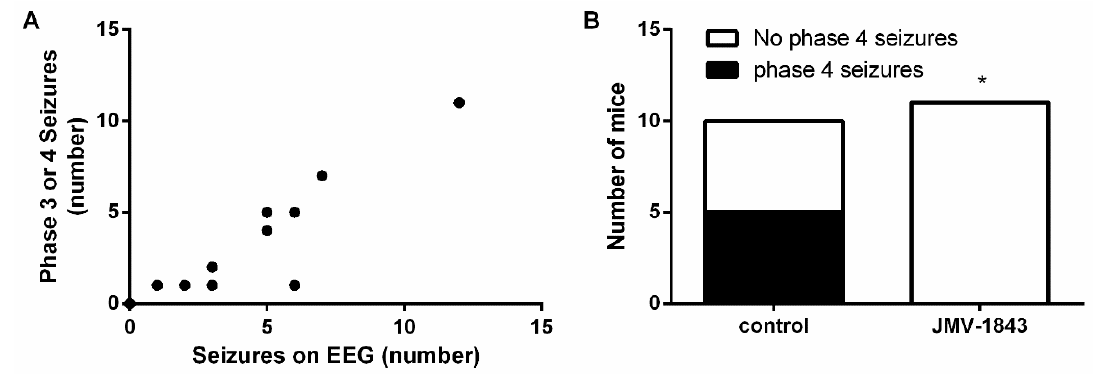
Figure 3. JMV-1843 treatment abolishes Phase IV seizures in the SKF81297-mediated kindling model. ( A ) Correlation between number of Phase III and IV seizures visually observed and number of hippocampal discharges on EEG (controls and JMV-1843-treated mice taken together; n = 16 pairs). Pearson correlation ( p < 0.0001; Pearson’s r = 0.9173). ( B ) 0 % of JMV-1843-treated mice ( n = 11) experienced Phase IV seizures while 50% of saline-treated controls ( n = 10) did. Fisher’s exact test ( p < 0.05). * p < 0.05; EEG, electro-encephalography.